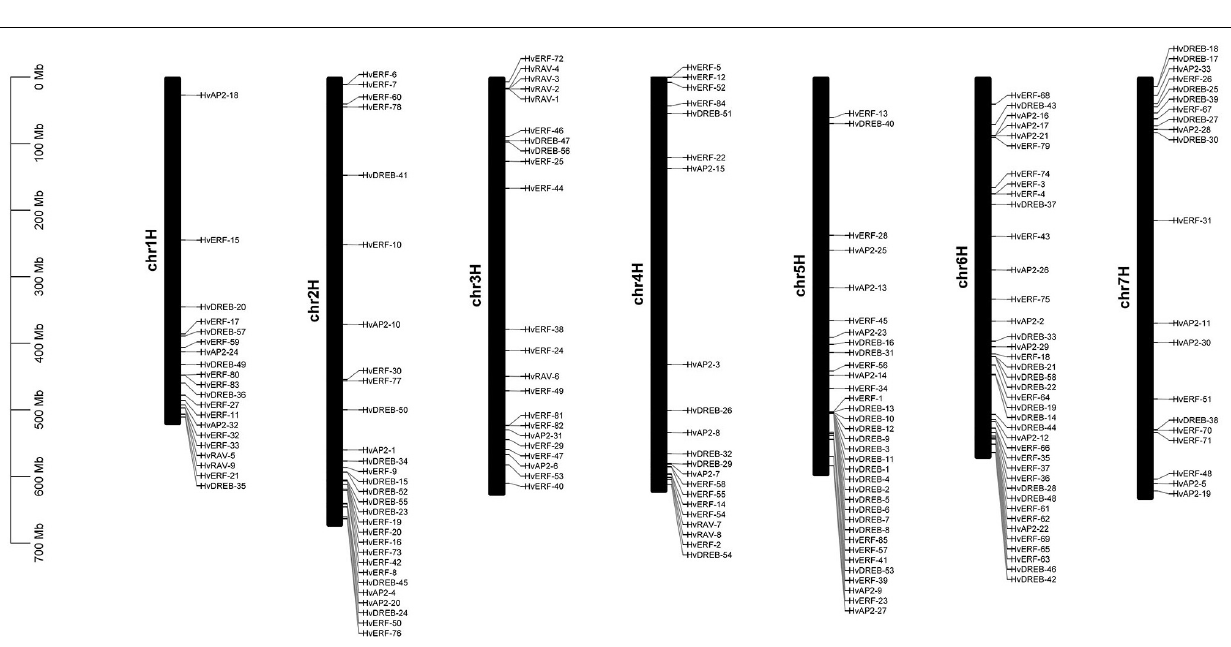
Frontiers in Plant Science |